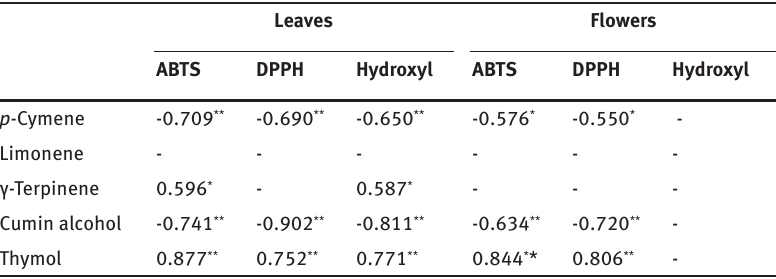
Table 4 : Spearman correlation coefficients among compounds and antioxidant activity. Leaves